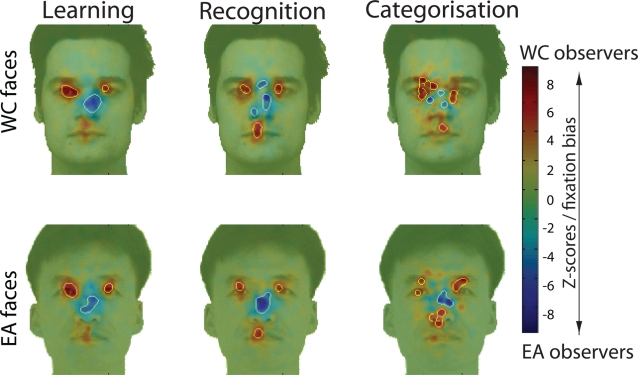
Fixation biases for Western Caucasian (WC - red) and East Asian (EA - blue) observers are highlighted by subtracting WC and the EA Z-scored fixation distribution maps during WC and EA face learning, recognition and categorization by race.Areas showing a significant fixation bias are delimited by white borders (Zcrit>|4.25|; p<.05); values near 0 indicate similar magnitude in fixation between observers from different cultures.